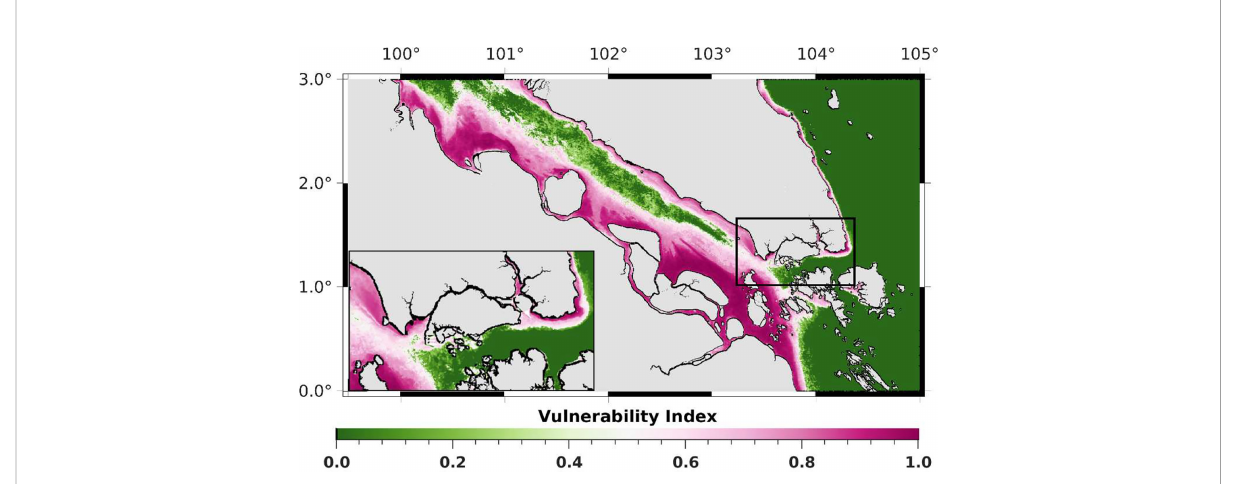
FIGURE 9 Sentinel-OLCI derived mean (2017-2020) distribution of vulnerability index of photic zone compression across Sunda shelf